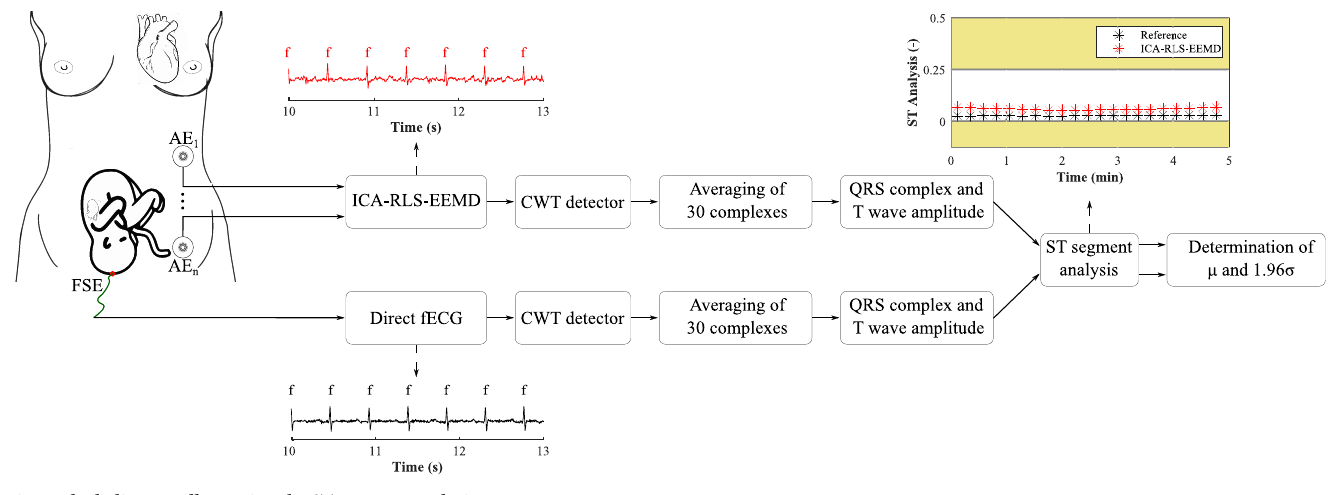
Fig 7. Block diagram illustrating the ST segment analysis